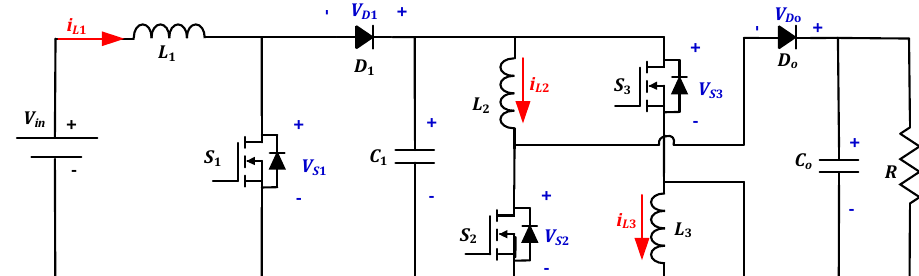
Figure 2. The proposed configuration.